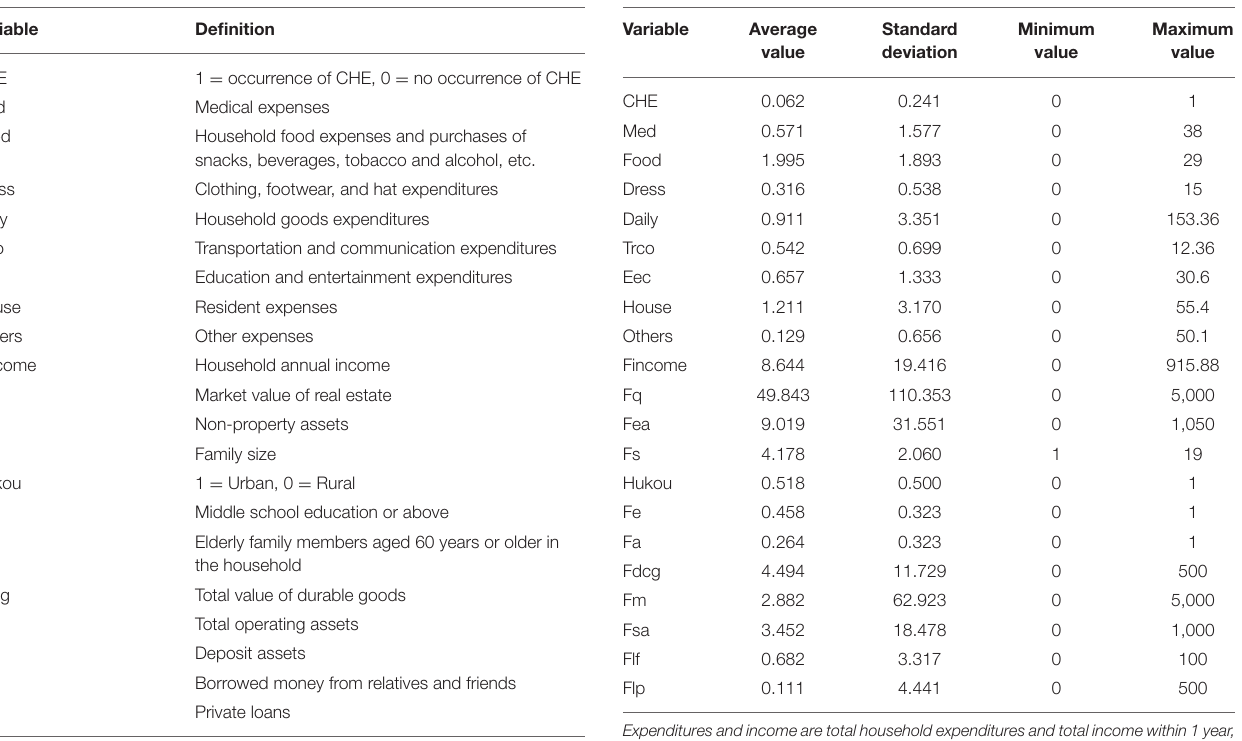
TABLE 1 | Definitions of the variables. TABLE 2 | Descriptive statistics of the major